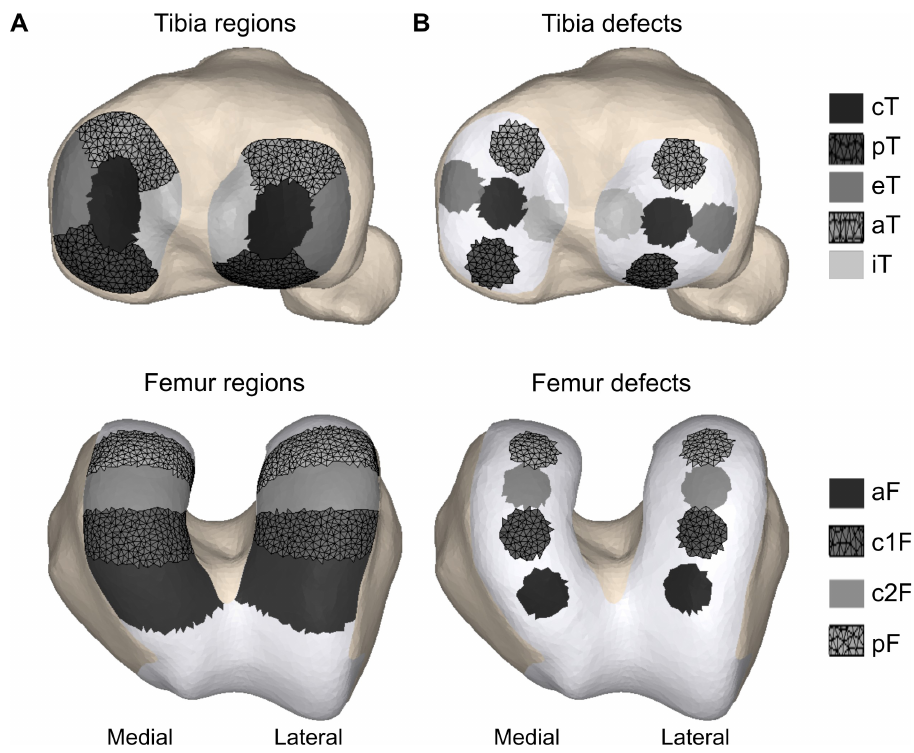
Fig 1. Model adaptations to simulate different cartilage defect locations in the tibia and femur articular surface. (A) To define the cartilage defect regions the tibia and femur articular surface were divided in 10 and 8 sub-regions, respectively. The medial and lateral tibia cartilage surfaces were each divided into five regions; cT—central, iT— internal, eT—external, aT—anterior and pT—posterior [58]. An ellipsoid defining the central tibia region covers 20% of the total cartilage area. The femur cartilage was first divided in medial and lateral compartment by a plane through the intercondylar notch perpendicular to the axis of the cylinder fitted onto the cartilage surface. Around the cylindrical axis, four angular segments of 30 degrees in anterior-posterior direction relative to the intercondylar notch were defined (aF—anterior, c1F - anterior-central, c2F - posterior-central and pF—posterior). (B) Circular defects of 100 mm 2 were defined in the center of the defined sub-regions of the tibia and